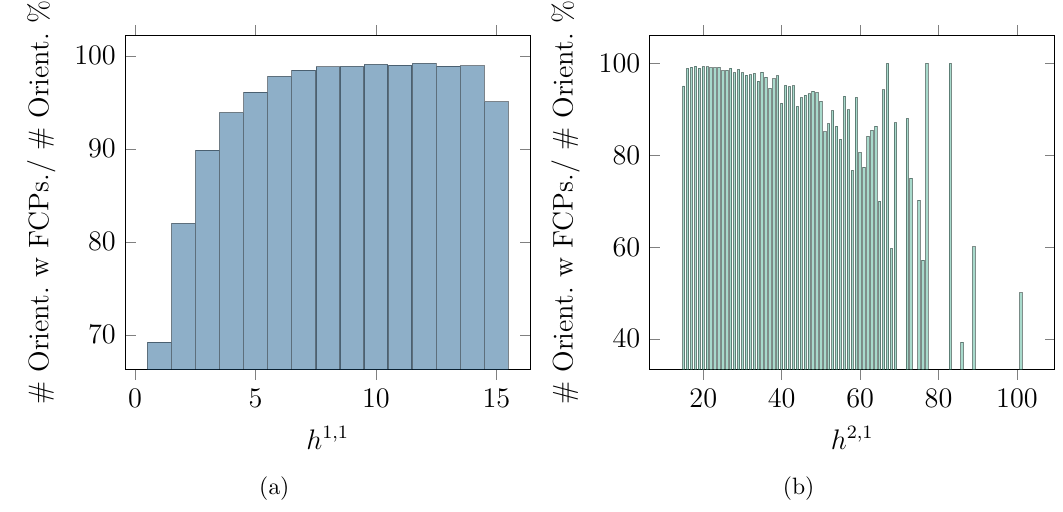
Figure 2 . Percentage of orientifolds admitting frozen conifold points, with respect of the total number of orientifolds, distributed by h 1 , 1 and h 2 , 1 . We remark that we are only analyzing favorable CICYs, therefore the cutoff at h 1 , 1 = 15 .